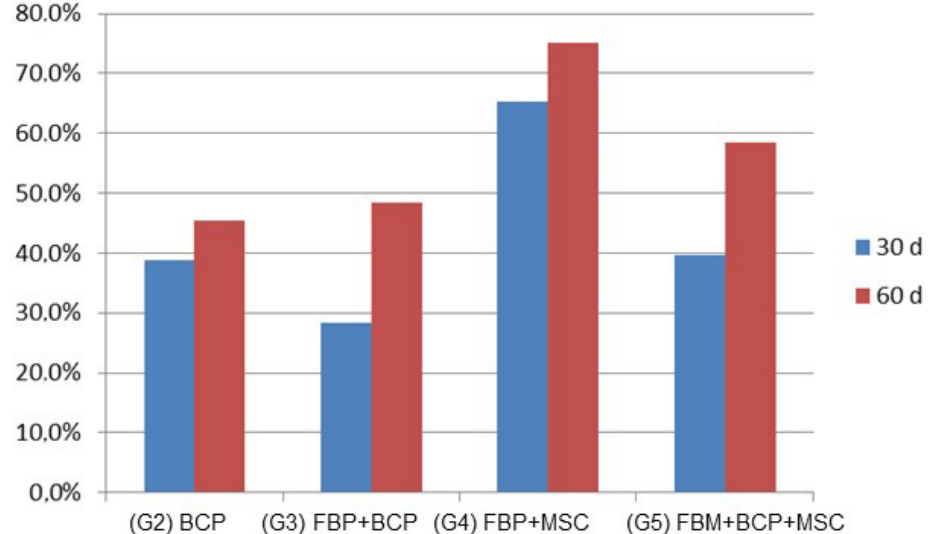
Figure 13. Relative quantification of progression of bone formation of treated groups 30 and 60 days after procedure observed in histological